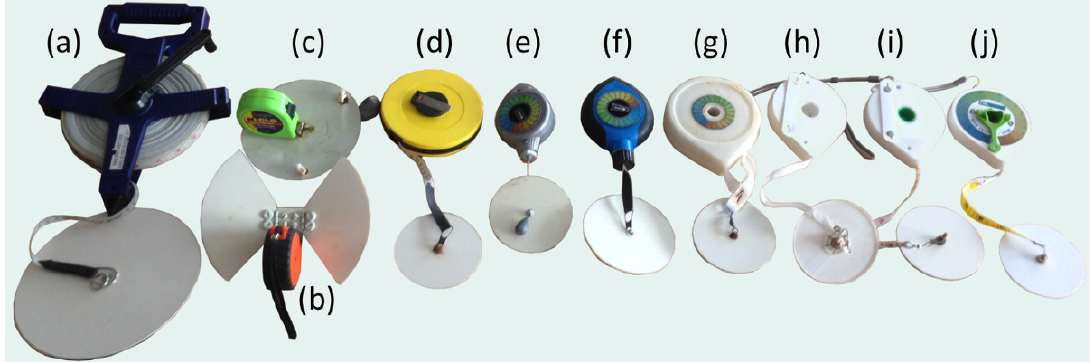
Figure 1. Mini-Secchi disk prototypes. ( a ) Traditional Secchi disk for use in lakes and nearshore waters (20cm sized Secchi disk); ( b ) and ( c ) prototypes based on the use of retractable tape measures and foldable Secchi disks; ( d – f ) prototypes based on attaching a 10cm disk to a series of small manually-operated tape measures and chalk lines; ( g – i ) initial 3D printed prototypes with 10cm Secchi disks; and ( j ) the current 3D printed version of the mini-Secchi